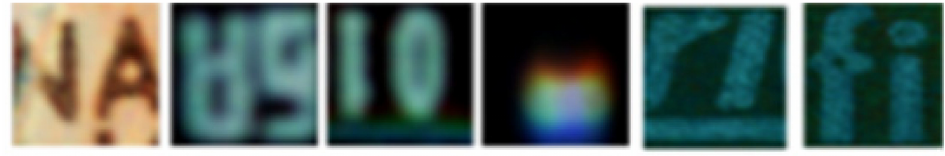
Figure 3. Examples of images with